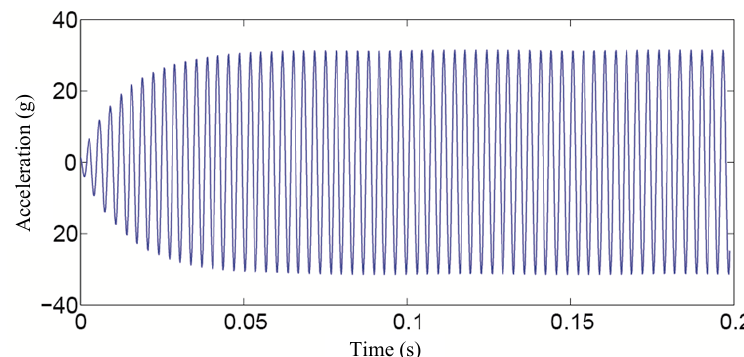
Figure 8. Acceleration response under excitation from base.